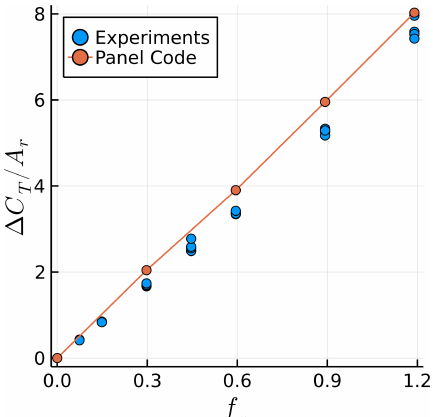
Figure 6. UNAFLOW wind turbine (grey), wake panels (blue), and PIV plane